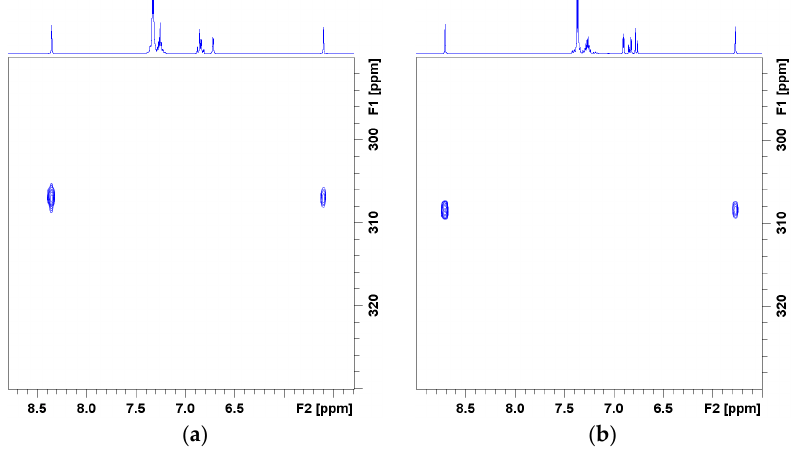
( a ) Figure D11. 1 H– 15 N HMBC NMR spectra of pOHsaladpm in ( a ) CDCl 3 and ( b ) DMSO-d 6 . Figure D11. 1 H– 15 N HMBC NMR spectra of pOHsaladpm in ( a ) CDCl 3 and ( b ) DMSO-d 6 . Figure D11. 1 H– 15 N HMBC NMR spectra of pOHsaladpm in ( a ) CDCl 3 and ( b ) DMSO-d 6 . Figure D11. 1 H– 15 N HMBC NMR spectra of pOHsaladpm in ( a ) CDCl 3 and ( b ) DMSO-d 6